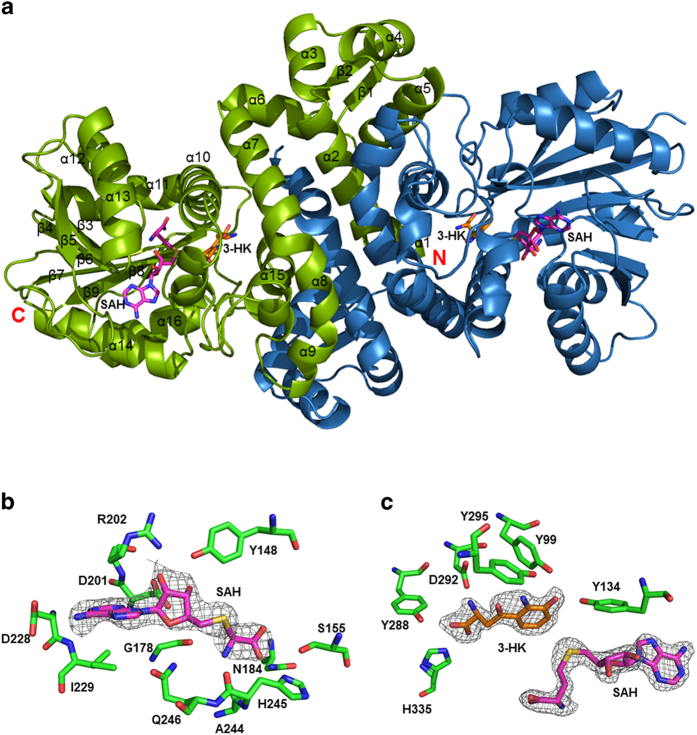
Structure of the Ss-SibL protein. (a) Ribbon representation of the dimeric Ss-SibL structure is viewed down its 2-fold axis. Subunits A and B are shown in green and blue, respectively. The SAH and 3-HK are shown as magenta and orange stick models. (b) and (c) The composite omit maps for the ligands in the binary and ternary complex crystals are contoured at the 1.5 σ level and drawn as grey mesh presentations. Each subunit of the bound Ss-SibL includes both SAH and 3-HK in the cleft. SAH is depicted as sticks with the carbon, oxygen, nitrogen, and sulfur atoms in magenta, red, blue, and yellow, whereas 3-HK is illustrated with the carbon, oxygen, and nitrogen in orange, red, and blue, respectively.